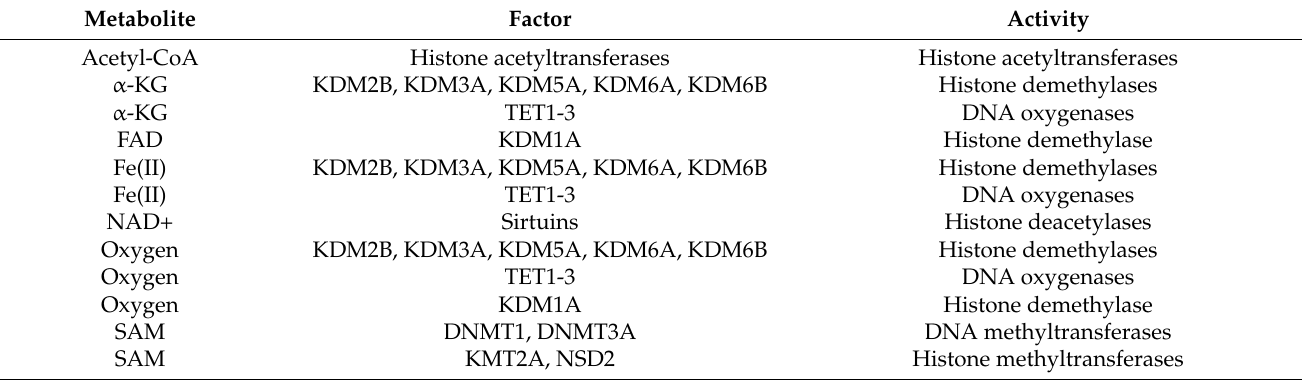
Table 1. Examples of epigenetic modifying enzymes whose activity is affected by specific metabolites.